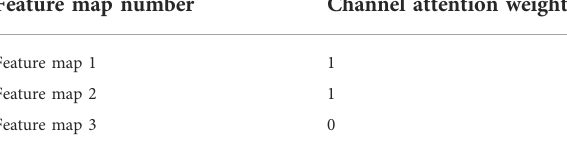
TABLE 5 Channel attention weights corresponding to different feature maps. Feature map number Channel attention